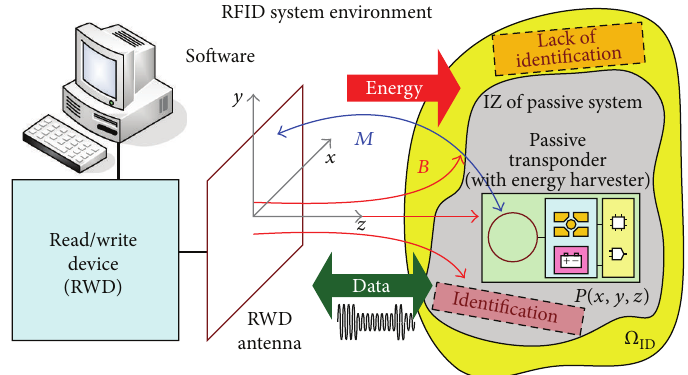
Figure 2: Passive RFID system with inductive coupling and energy harvesting